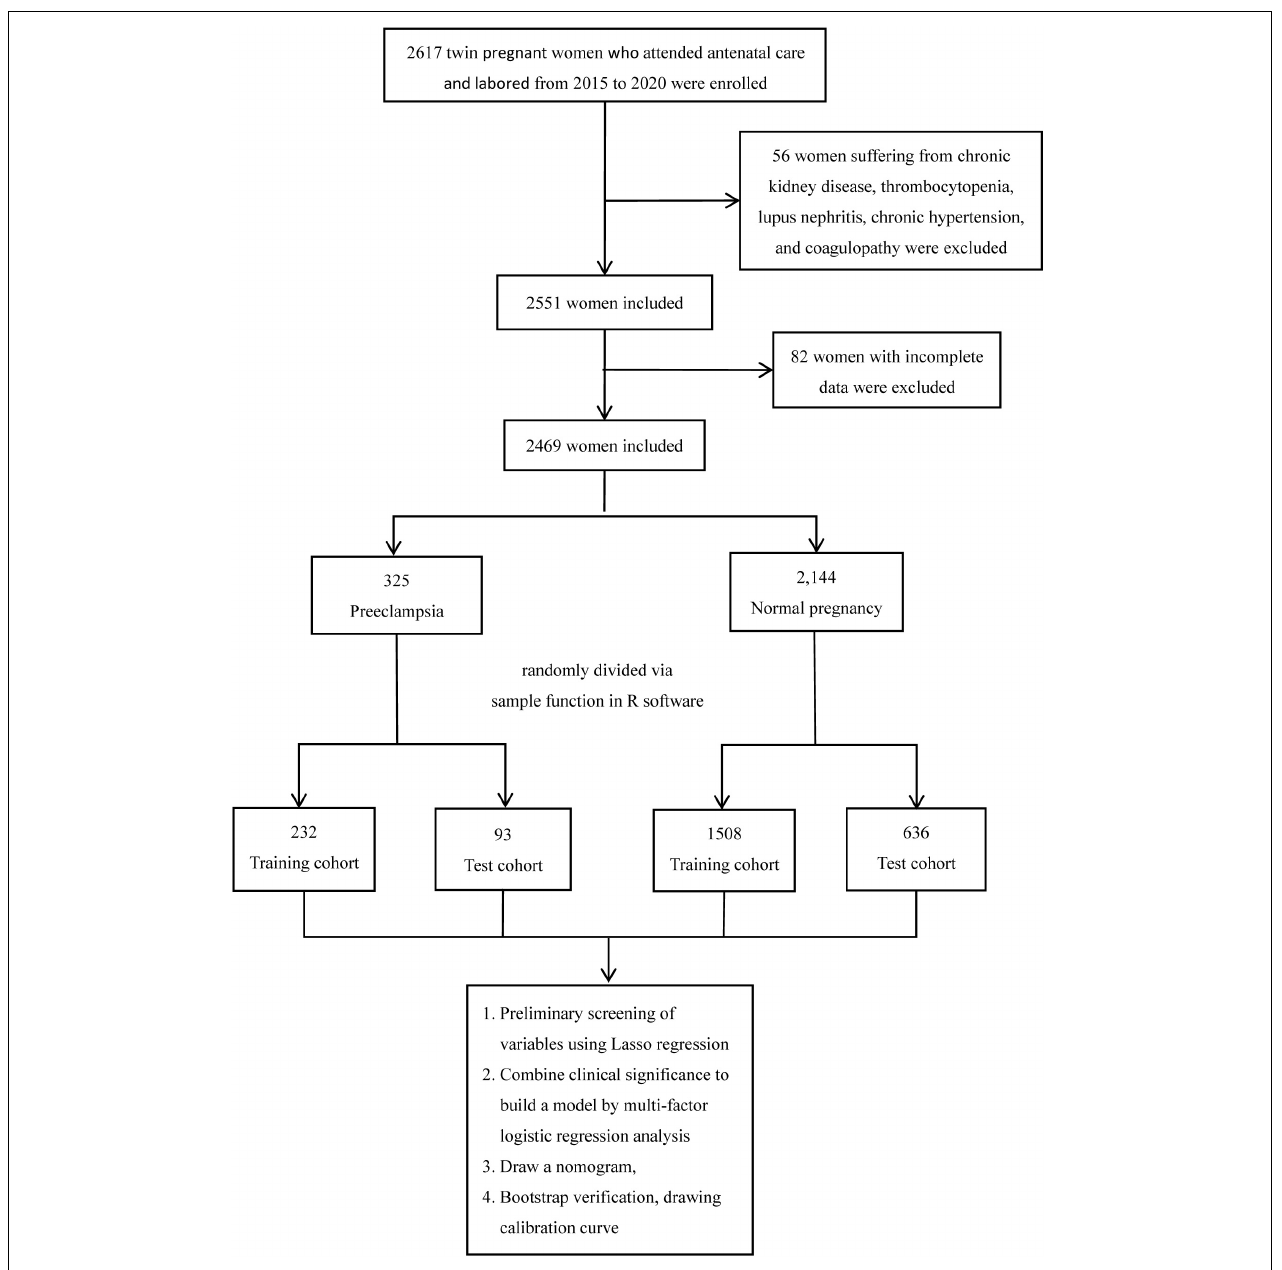
FIGURE 1 | Flowchart of participant selection for the study